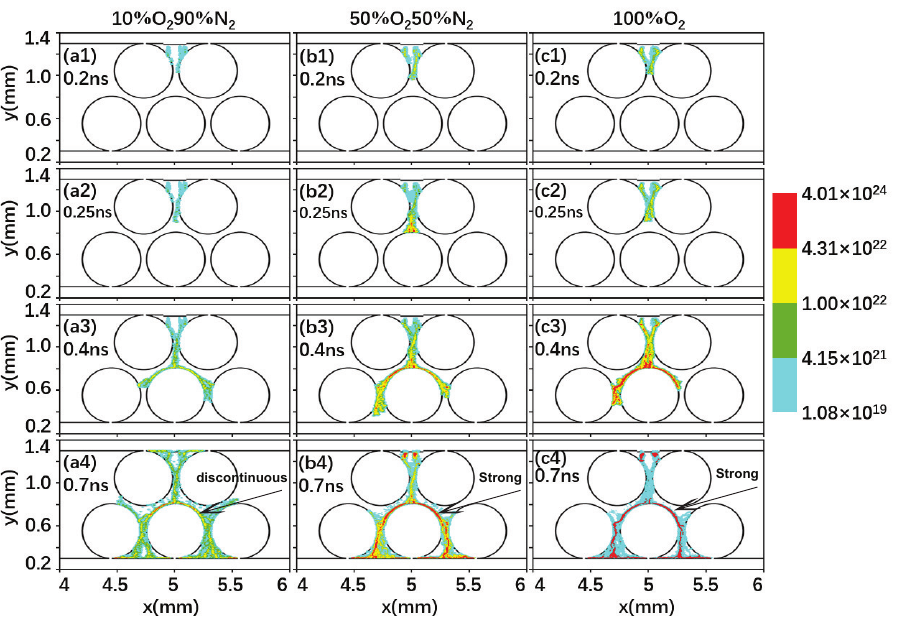
Figure 11. O − ion density (m − 3 ) for the same conditions as in Figure 2